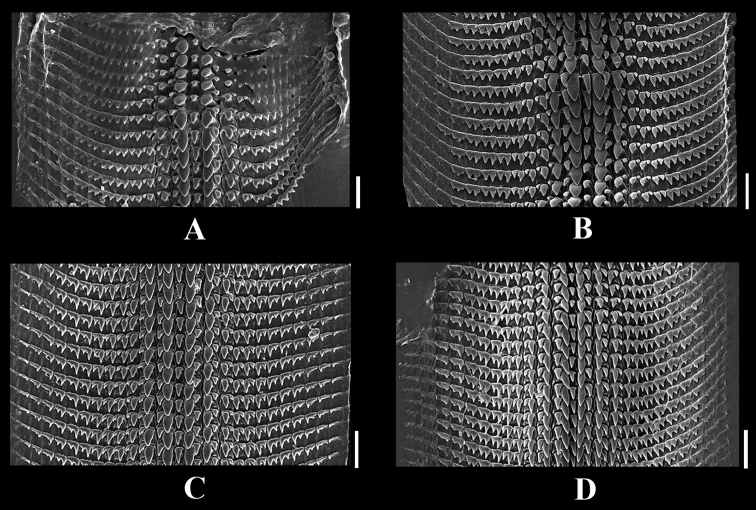

Radula of Aulacospira spp. AA.
depressaBA.
khaopratunCA.
panhaiDA.
smaesarnensis. Scale bars: 20 µm.